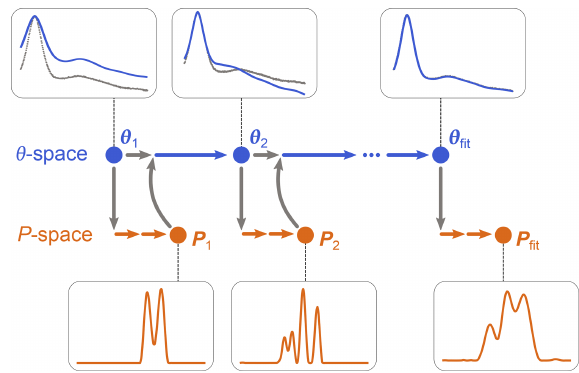
Figure 3. One-step analysis of dipolar signals using separable non- linear least-squares optimization. A set of parameters θ n (blue) is computed by optimization of Eq. (18) for some given experimental signal V exp (grey dots). For each θ n , a corresponding distance dis- tribution P n (orange) is computed by optimization of Eq. (19). This procedure is repeated until a minimum of the objective function is found for an optimal parameter set θ fit , leading to the corresponding optimal distribution P fit